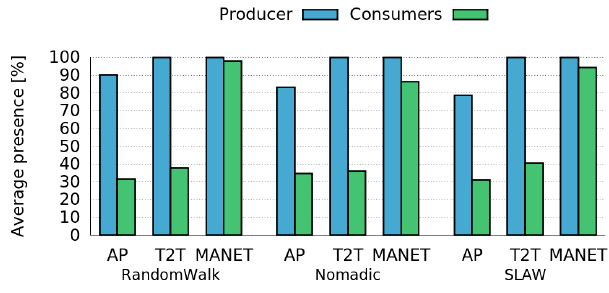
Figure 11. Presence of the Producer and the Consumers for different mobility patterns using an ideal Control Tier.